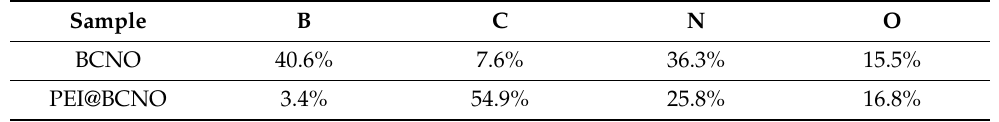
Figure 4. ( a ) XPS C1s spectrum of BCNO ( b ) XPS N1s spectrum of BCNO ( c ) XPS C1s spectrum of PEI@BCNO ( d ) XPS N1s spectrum of PEI@BCNO. Table 1. XPS surface elemental composition of BCNO and